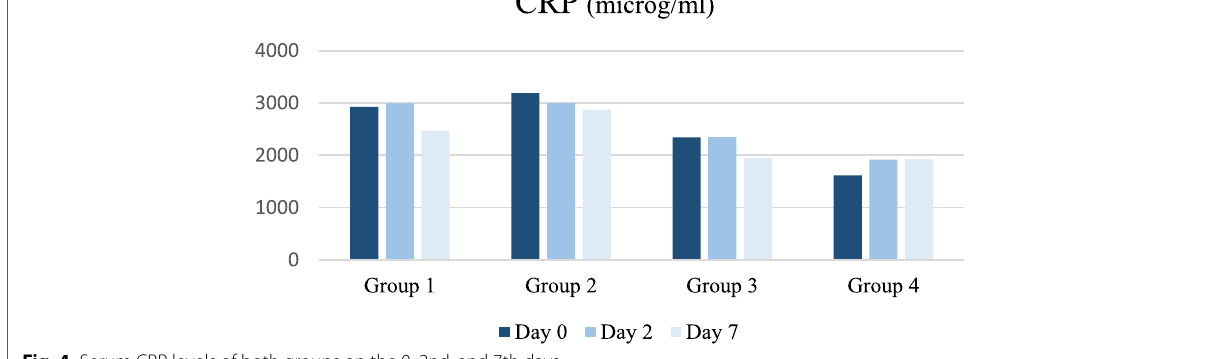
Fig. 4 Serum CRP levels of both groups on the 0, 2nd, and 7th days